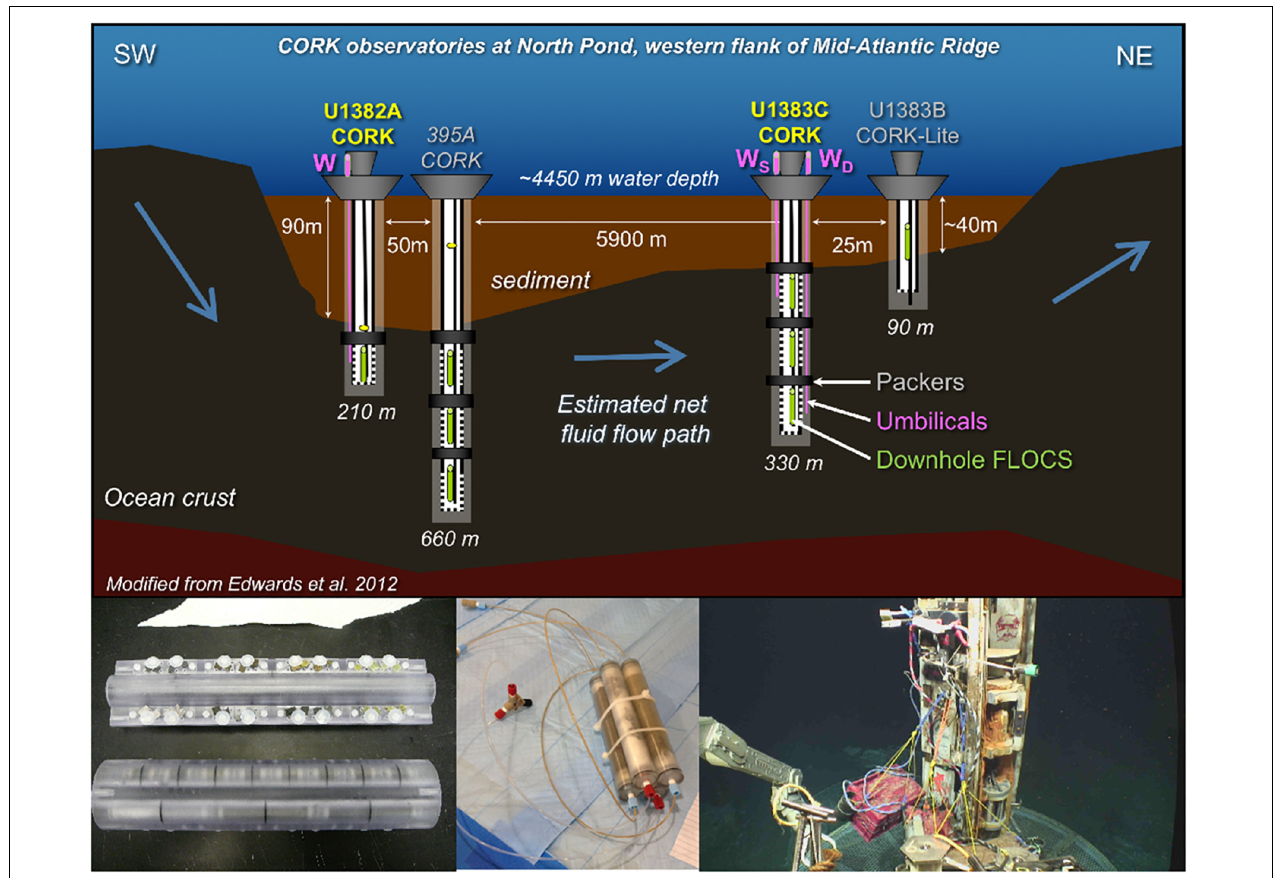
FIGURE 1 | Overview of sampling from the North Pond crustal subsurface for this study. (Upper) : Schematic of FLOCS colonization experiments and fluid sampling from CORK observatories installed during IODP Expedition 336. The primary locations targeted in this study – Holes U1382A and U1383C – are highlighted in yellow. FLOCS colonization experiments were deployed both downhole (green) and at the wellheads of the CORKs and accessing crustal fluid sourced from depth via stainless steel umbilical tubing (pink, with W S representing a FLOCS sourcing the shallow sealed horizon at W D sourcing the deeper sealed horizon). Figure modified from Edwards et al. (2012) with permission. (Lower) Left : Photograph of downhole FLOCS colonization experiment. Reprinted with permission from Edwards et al. (2012). Middle: Photograph of wellhead FLOCS experiment. Right: Deployment of wellhead FLOCS experiments in a milkcrate with OsmoSamplers connected to CORK wellhead umbilical. Photo courtesy RV Atlantis cruise AT39-01 ROV Jason dive J2-1032, 2017, chief scientist Geoff Wheat, University of Alaska Fairbanks, US National Science Foundation, ©Woods Hole Oceanographic